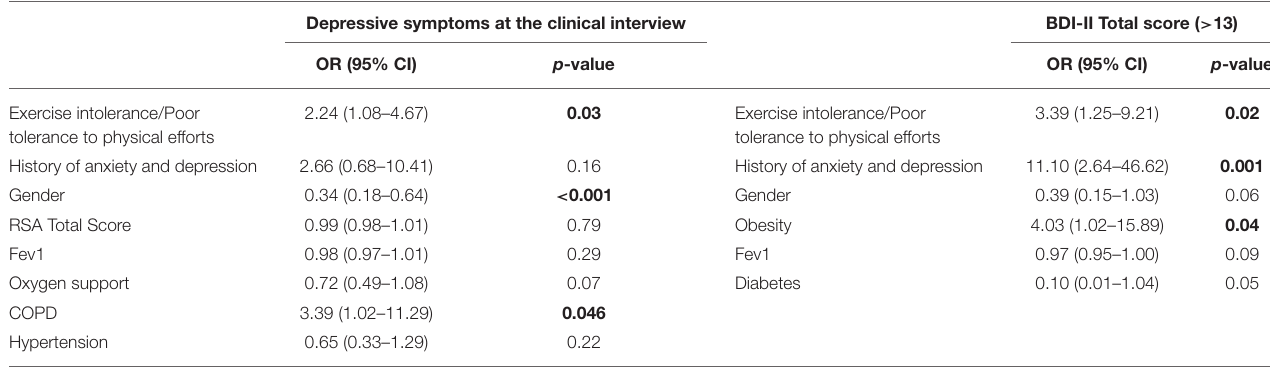
TABLE 6 | Logistic regression model for depressive symptoms as assessed at the psychiatric interview and with the BDI-II. Depressive symptoms at the clinical